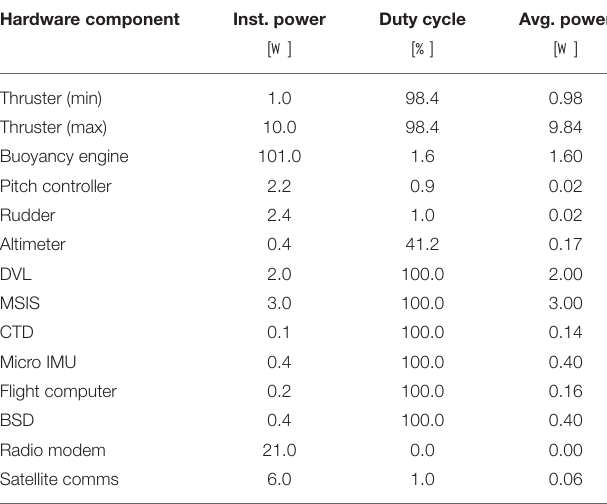
TABLE 1 | Review of hardware components including instantaneous power draw when the component is active, the expected duty cycle during a typical glider mission, and the average power draw over the course of the